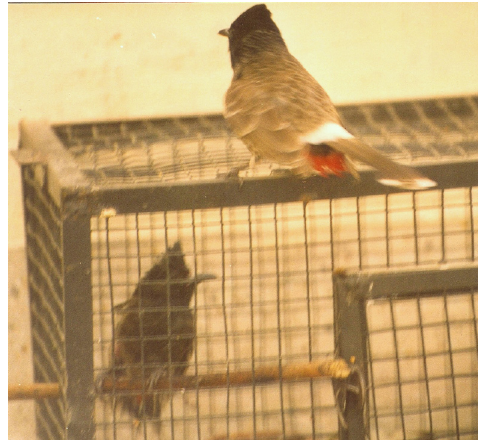
Image 4. Display of red-vent feathers during Greeting